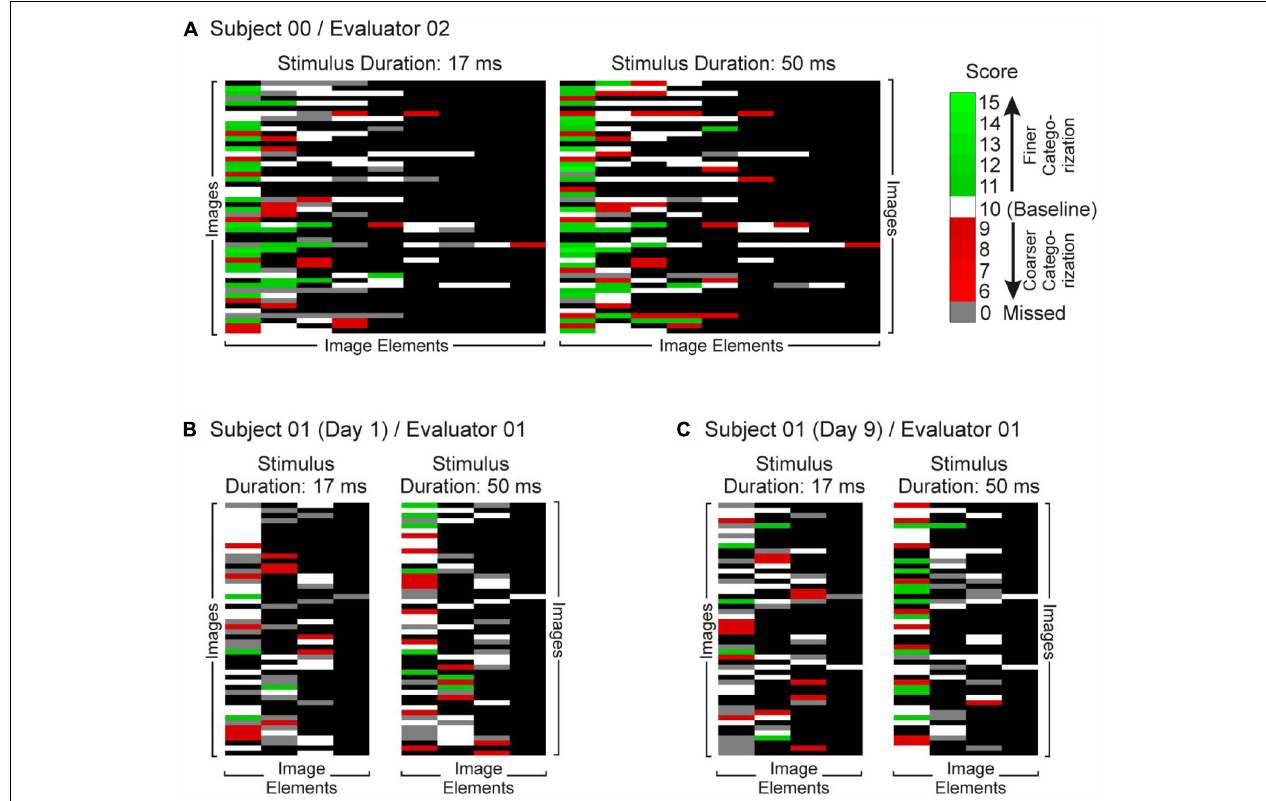
FIGURE 4 | Comparison of subjects’ reports for the short (17 ms) and long (50 ms) stimulus durations. Subjects viewed images for either stimulus duration, and reported their percepts using the paradigm illustrated in Figure 2 . Subjects’ reports were scored by an evaluator as illustrated in Figures 1 and 3 , and the resulting scores are shown in this figure in color-coded fashion. Panels A though C show data from three different, representative data sets, each obtained using the same set of images. Each row in each panel shows the numeric representation of a single verbal report. Rows are matched across panels A–C , so that, for instance, row 7 in each panel denotes reports of the same image by different subjects and/or during different sessions. Each column denotes a different descriptor. Note that the columns are not necessarily matched across panels A–C (although they’re exactly matched within each panel), because the subjects did not necessarily describe the same set of image